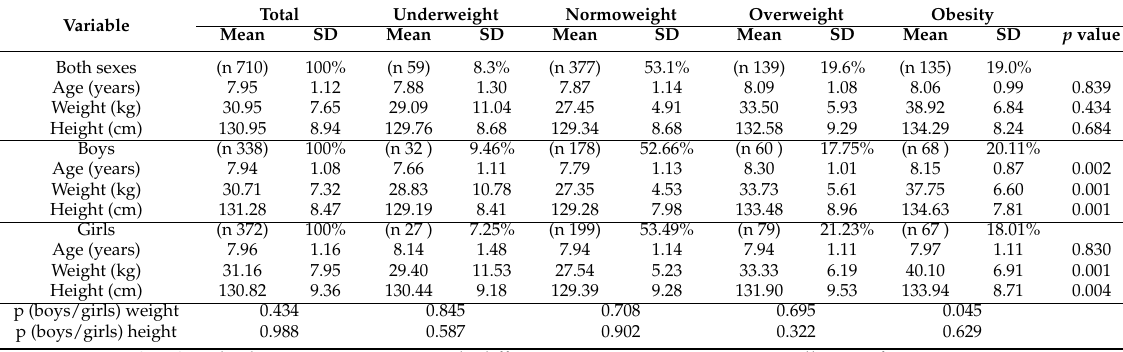
Table 1. Characteristics of the sample, according to BMI, in the 6–9 years old schoolchildren of both genders. Variable